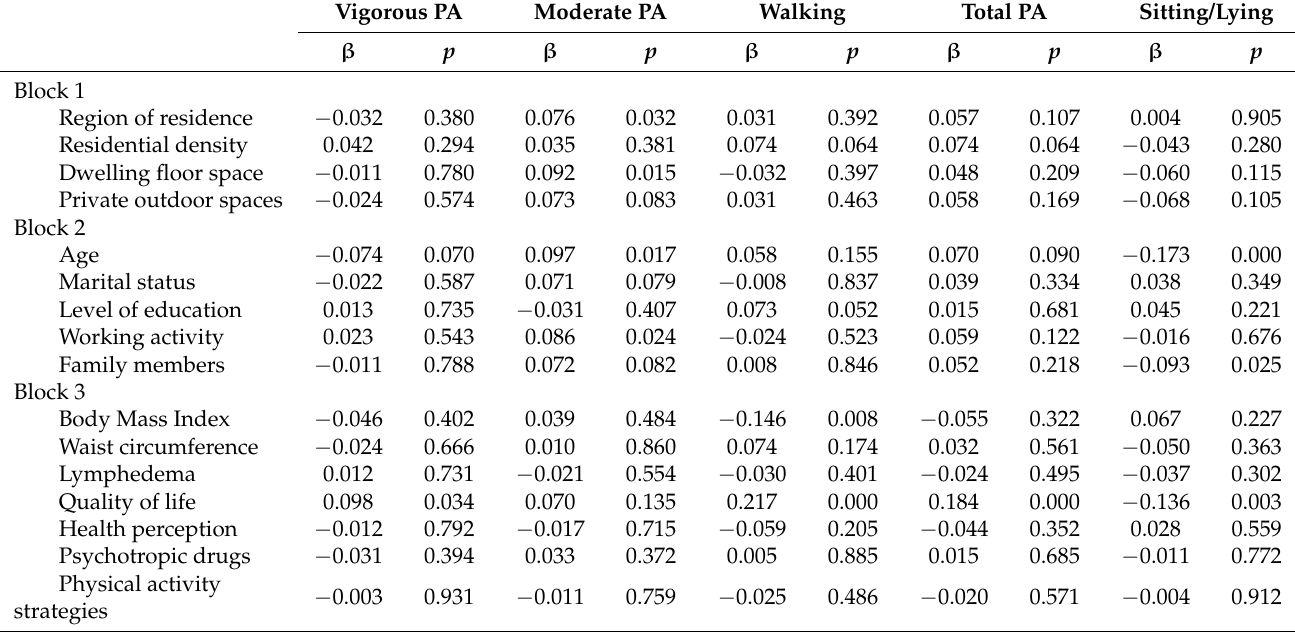
Table 6. LMR between possible independent predictors and physical activity level (MET-min/week) or sitting/lying time (h/day) in the DianaWeb cohort during